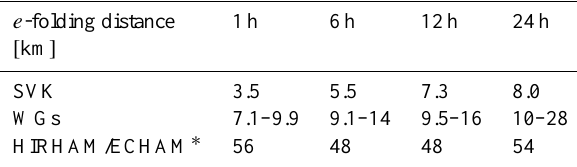
Table 5. e -folding distances for the SVK and WG maximum- averaged intensities of extremes for 1, 6, 12, and 24h duration, based on the fitted exponential models (cf. Fig. 8) as well as for a regional climate model (HIRHAM/ECHAM) from the study by Gregersen et al. (2013) for